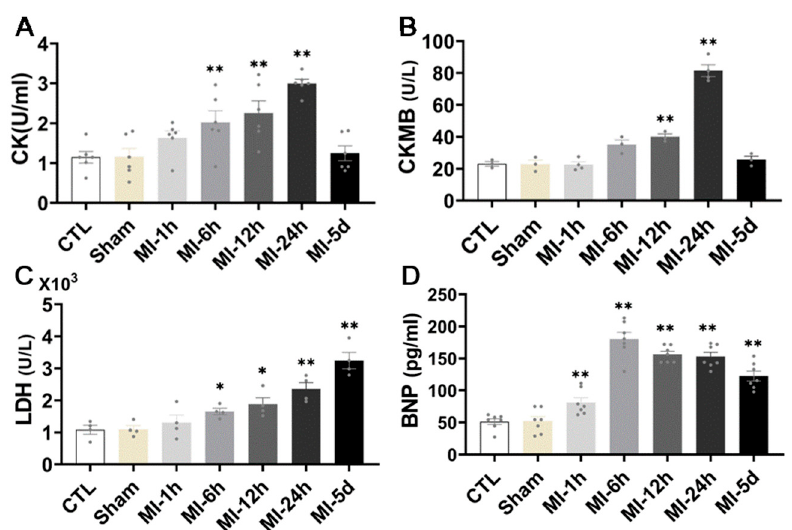
Figure 3. Effect of MI on myocardial injury. ELISA kit analysis of myocardial injury level, CK ( A ), CKMB ( B ), LDH and BNP ( C , D ) in rat serum ( n = 6). Values presented are the means ± SEM. CTL, normal control; sham; MI-1 h, 1 h after myocardial infarction; MI-6 h, 6 h after myocardial infarction; MI-12 h, 12 h after myocardial infarction; MI-24 h, 24 h after myocardial infarction; MI-5d, 5 days after myocardial infarction (* p < 0.05, ** p < 0.01 vs.